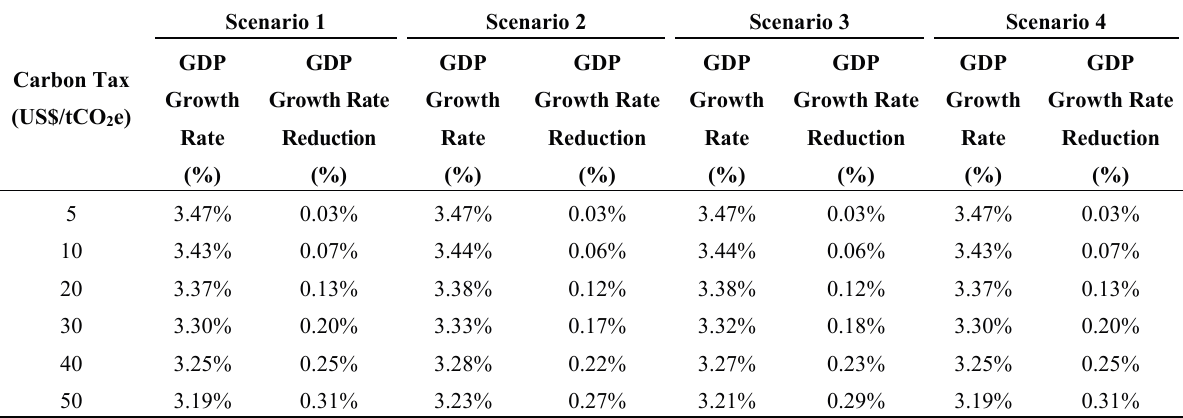
Table 5. Impact of carbon tax on the annual GDP growth